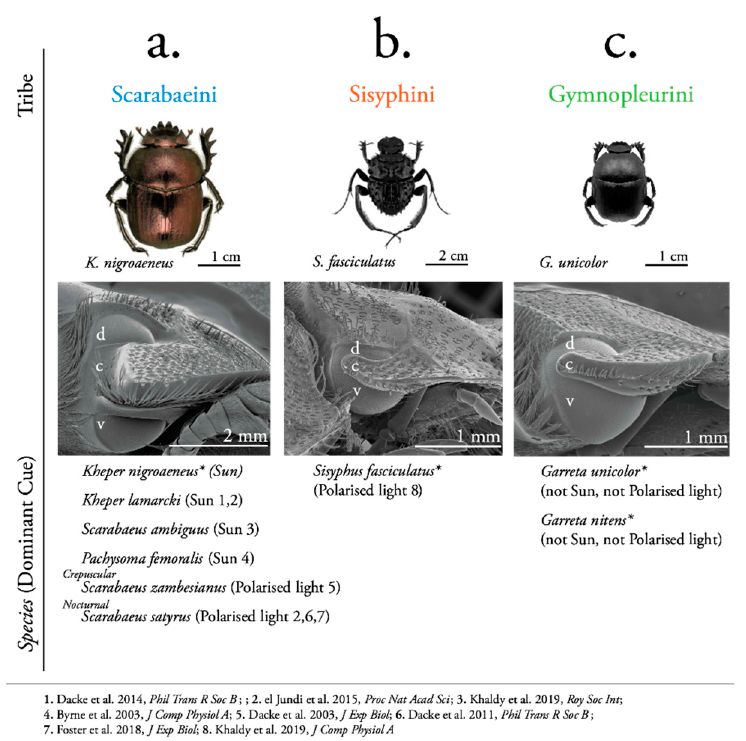
Figure 2. Habitus, eye design and dominant orientation cue in three tribes of ball-rolling dung beetles. Diurnal species within the tribe Scarabaeini ( a ) attribute greatest relative weight to directional information provided by the sun during straight-line orientation. In contrast, two nocturnal species from the same tribe, as well as the smaller, diurnal Sisyphus fasciculatus, from the tribe Sisyphini ( b ), rely predominantly on polarised skylight for directional information. The underlying weighting strategy for straight-line orientation within the tribe Gymnopleurini ( c ) differs from that previously mentioned, where neither directional information from the sun nor the polarisation pattern dominates the output from its compass network. As can also be noted from our test species, Sisyphini are generally much smaller than Gymnopleurini, which in turn are smaller than Scarabaeini. The relative eye sizes across the three tribes follow the same pattern, but they differ in shape. The canthus ( c ) completely separates the roughly equal sized dorsal ( d ) and ventral ( v ) eyes of the Scarabaeini, while the dorsal portion of the eye of the Gymnopleurini and Sisyphini is only partially separated and much smaller than the ventral part. Species tested in this study are indicated by an asterisk (*).